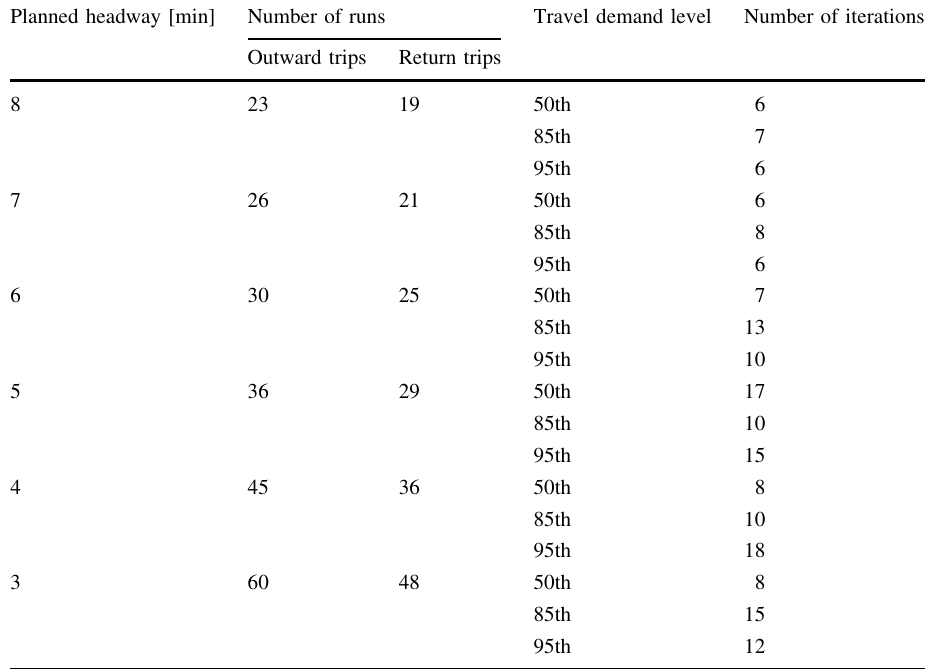
Table 1 Number of runs for each planned headway and number of iterations for each analysed